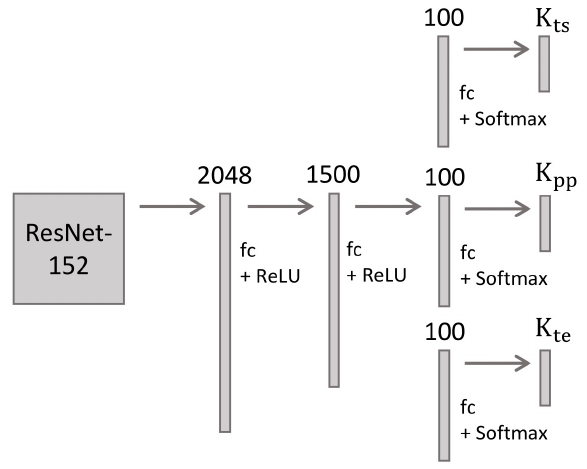
Figure 2. Network architecture for multi-task learning. fc: fully connected layers. ReLU: rectified linear unit. K ts , K pp and K te are the numbers of classes for production timespan , production place , technique ,